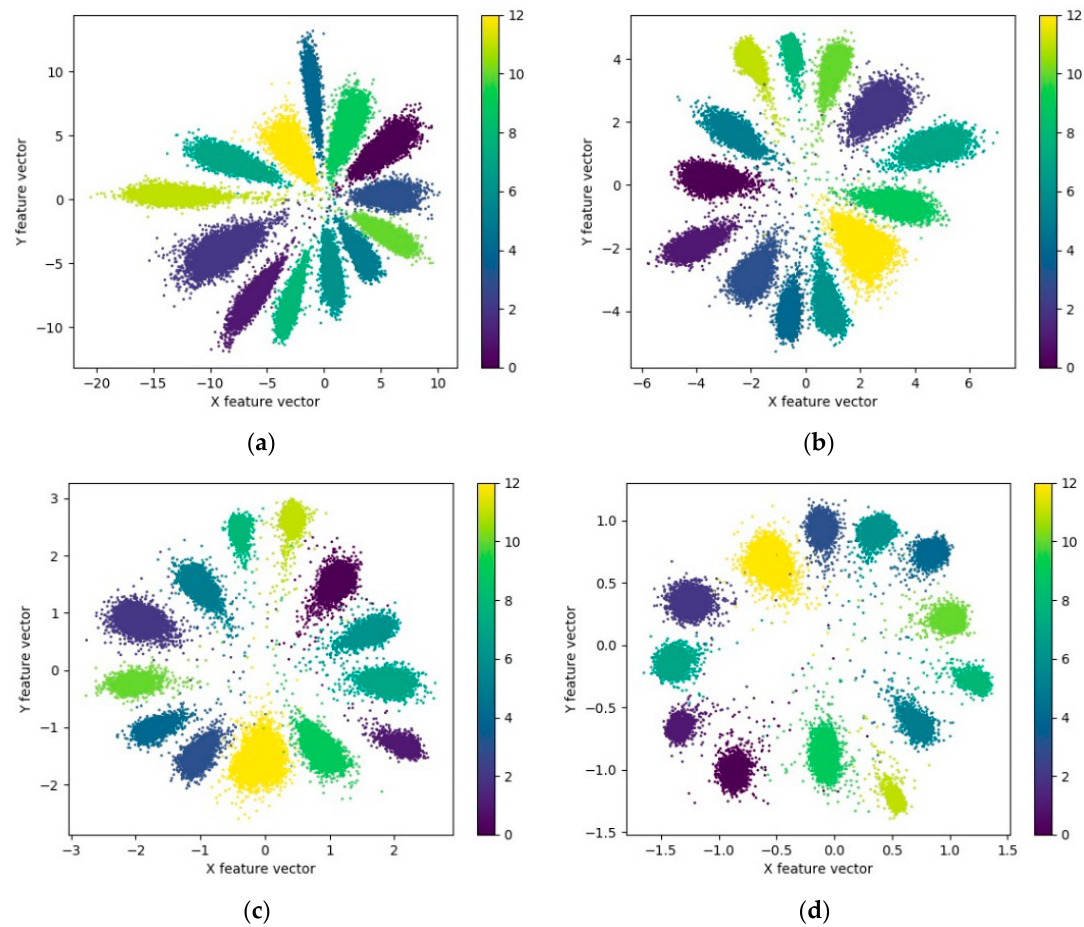
Figure 11. Visualization of the feature extracted by model A with different value of λ . ( a ) λ = 0.001; ( b ) λ = 0.01; ( c ) λ = 0.1; ( d ) λ = 1.